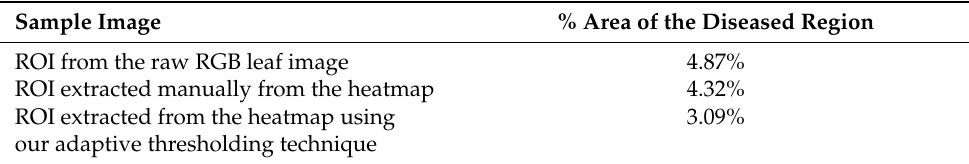
Figure 11. ROI extraction with ImageJ software. Table 2. Leaf disease